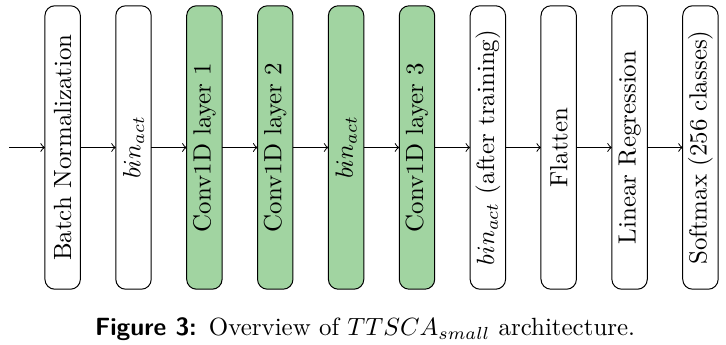
Figure 3: Overview of TTSCA small architecture.